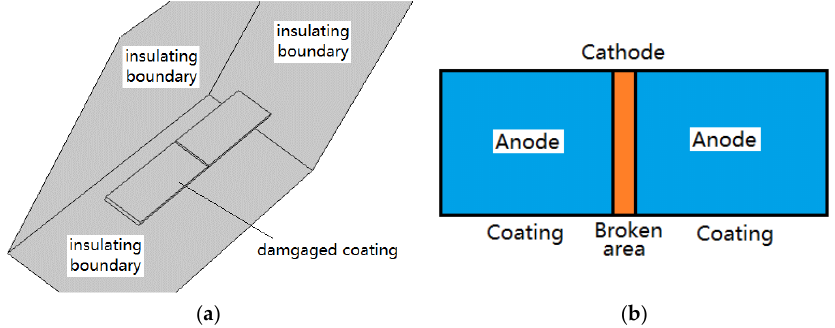
Figure 2. Schematic of computational domain for studying the cathodic protection effect: ( a ) whole simulation domain; ( b ) the surface of damaged coating samples.